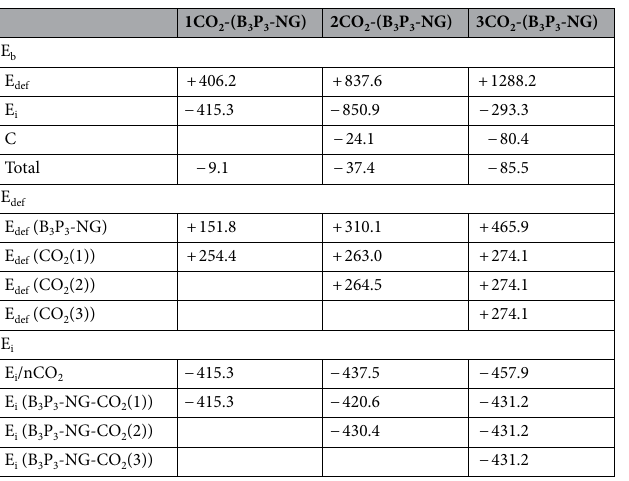
Table 1. Binding energy (Eb), total and individual deformation energies (E def ), total interaction energy (E i ), interaction energy for each individual contact with a CO 2 molecule (Ei B3P3-NG-CO2(n) ), mean interaction energy per CO 2 molecule (E i / n CO 2 ), cooperative energy (C) in kJ mol −1 for the different adducts obtained (M06-2X/6- 311++G(3df,3pd)//M06-2X/6-31+G*).